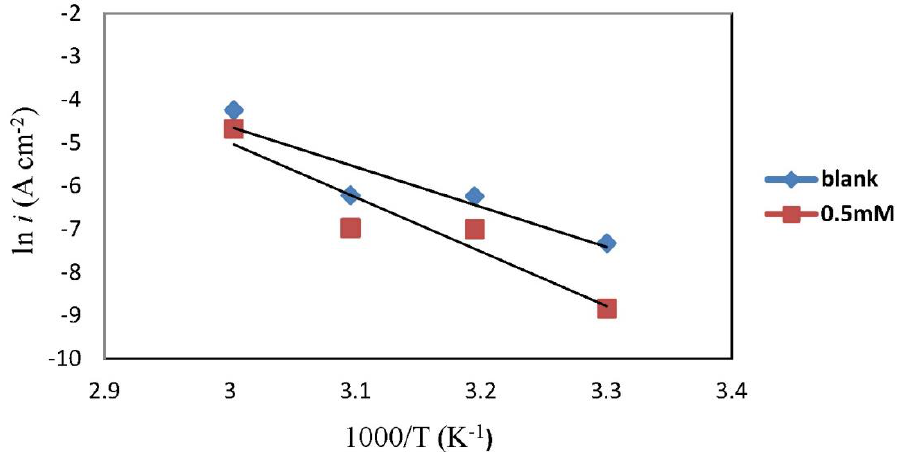
Figure 5. The values of E were calculated and are displayed in Table 3. a Figure 5. Arrhenius plot for mild steel in 1.0 M HCl.